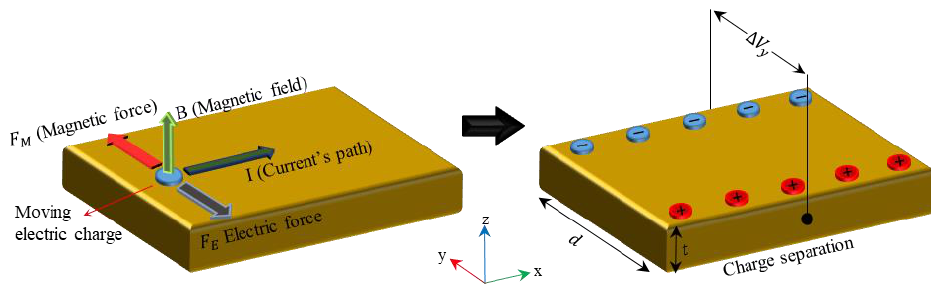
Figure 2. Charge separation in a conductive plate due to the Hall-effect phenomenon.